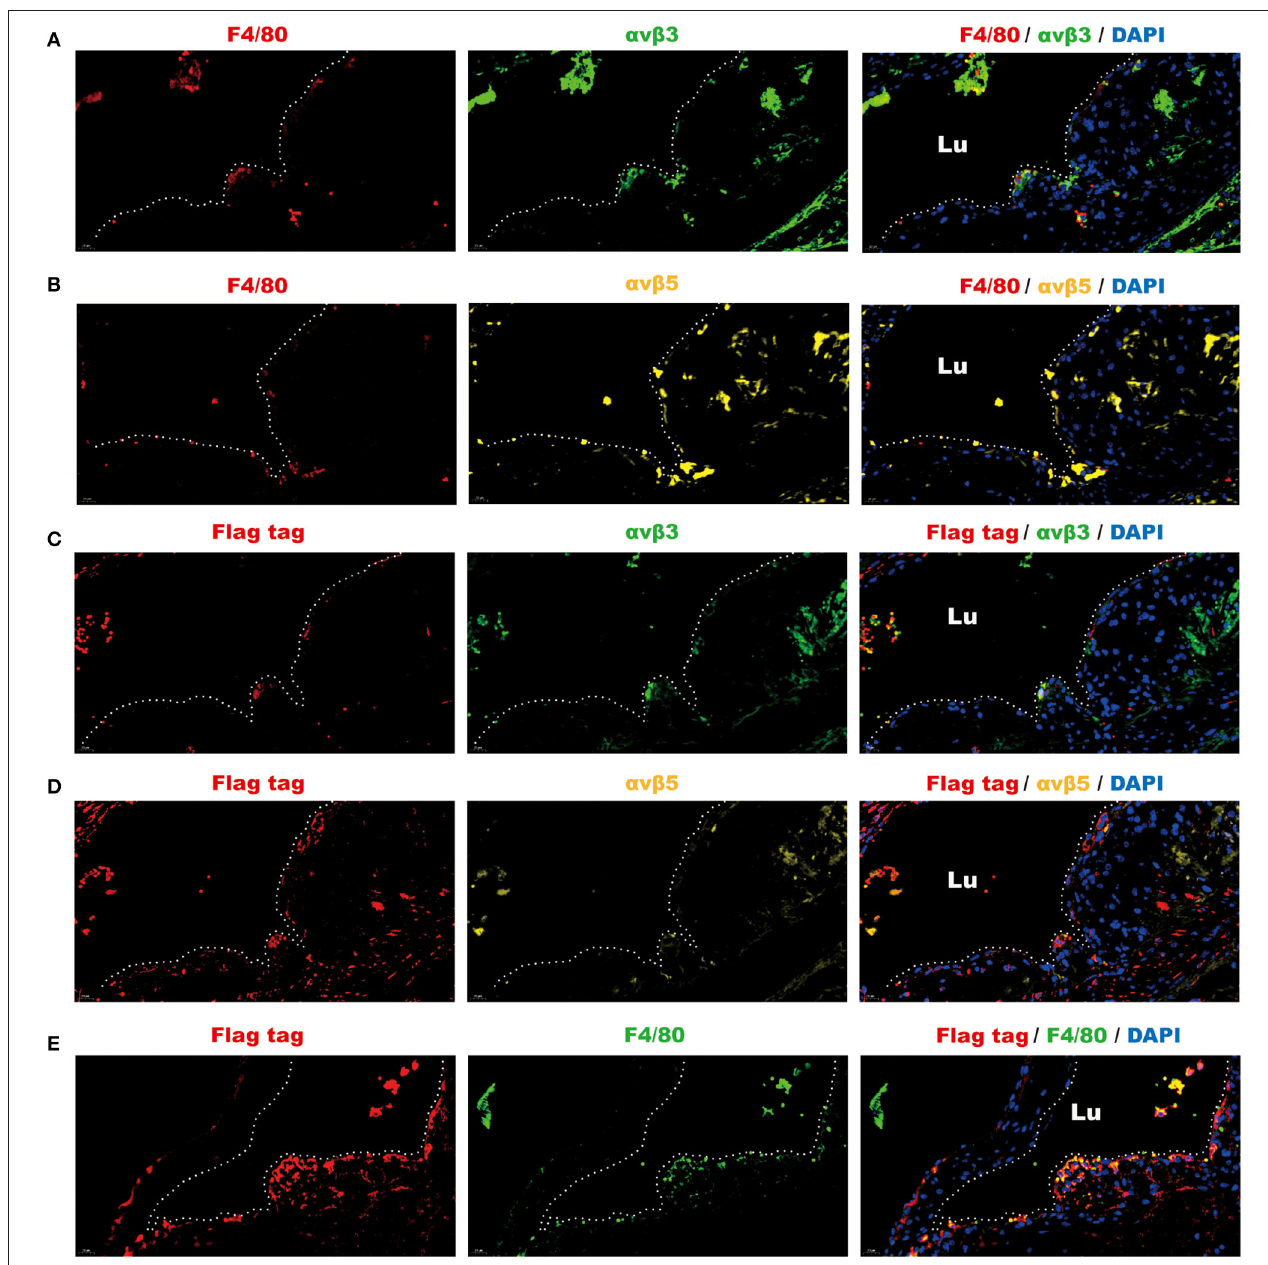
FIGURE 4 | Fluorescence analysis demonstrated the spatial co-localization of infiltrated macrophages, exogenous omentin-1 (labeled by flag tag), and integrin receptors in the atherosclerotic plaque of ApoE − / − mice. The aortic root sections were stained by primary antibodies against F4/80 (macrophage marker), α v β 3, α v β 5, and flag tag (the marker of exogenous omentin-1). Fluorescence secondary antibodies against protein from mice, rabbits, and rats were used to mark the localization of the primary antibodies. Three biological replicates were made in this analysis. (A) The macrophage (F4/80) was dyed red and α v β 3 was dyed green. The plaque area was marked by a dotted line. (B) The macrophage (F4/80) was dyed red and α v β 5 was dyed yellow. The plaque area was marked by a dotted line. (C) Flag-tagged exogenous omentin-1 (flag tag) was dyed red and α v β 3 was dyed green. The plaque area was marked by a dotted line. (D) Flag-tagged exogenous omentin-1 (flag tag) was dyed red and α v β 5 was dyed yellow. The plaque area was marked by a dotted line. (E) Flag-tagged exogenous omentin-1 (flag tag) was dyed red and macrophage (F4/80) was dyed green. The plaque area was marked by a dotted line (Lu = the lumen of the aorta).